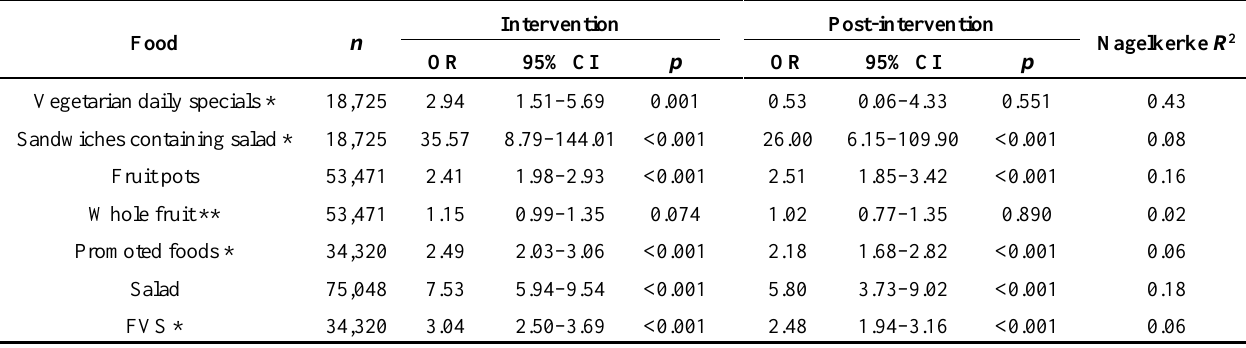
Table 2. Overall independent effect of time (intervention and post-intervention relative to baseline) on students’ selection of food